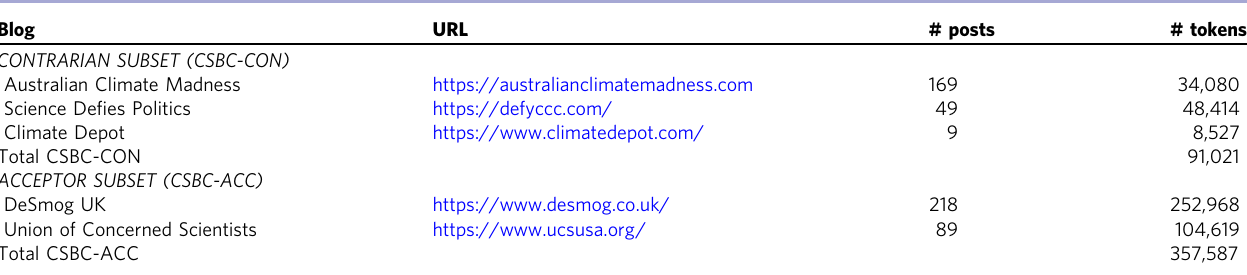
Table 1 Composition of the Genealogies of Knowledge Climate Science Blogger Corpus